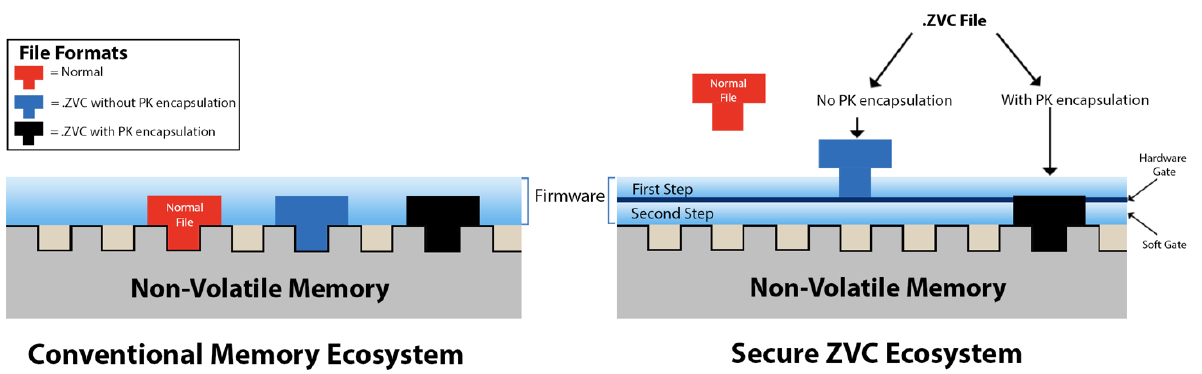
Figure 4. Hardware- and firmware-level exclusion of non-native data by ZVC to obliterate the attack surface.